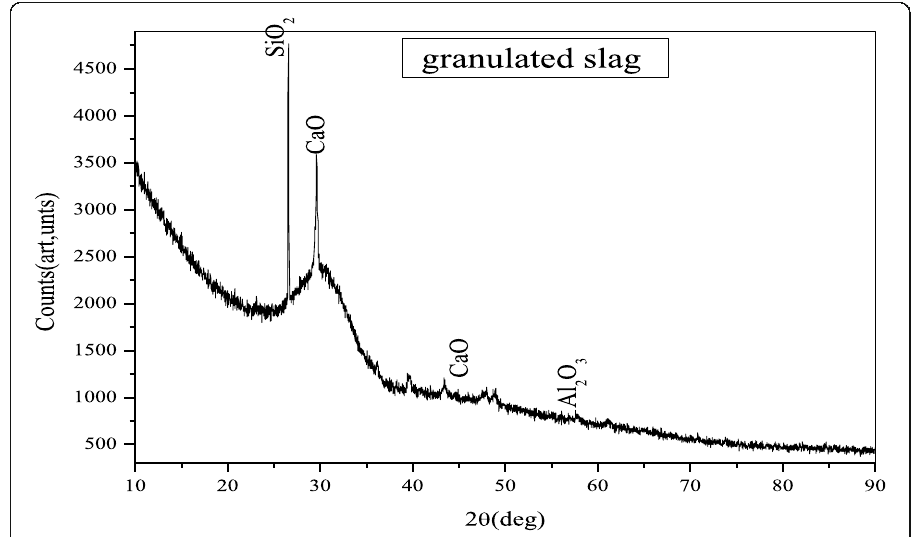
Fig. 1 Diffractogram of BF slag sample from the El-Hadjar complex